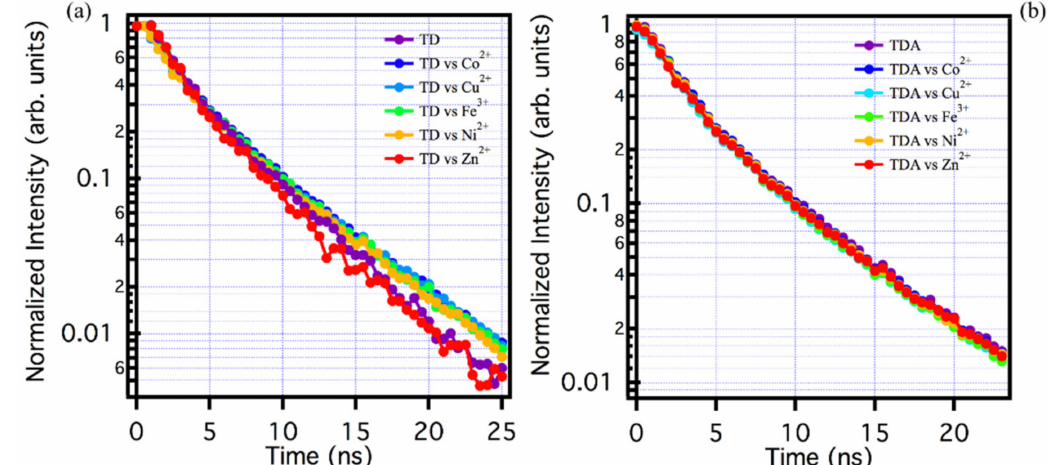
Figure 4. ( a ) Lifetime analysis for TD solutions with and without metals: pure TD (purple line), Co 2+ (blue line), Cu 2+ (light blue line), Fe 3+ (green line), Ni 2+ (orange line), and Zn 2+ (red line). ( b ) TDA lifetime analysis in solution with and without metals: pure TDA (purple line), Co 2+ (blue line), Cu 2+ (light blue line), Fe 3+ (green line), Ni 2+ (orange line), and Zn 2+ (red line). Lifetime has been always recorded at 520 nm under excitation at 440